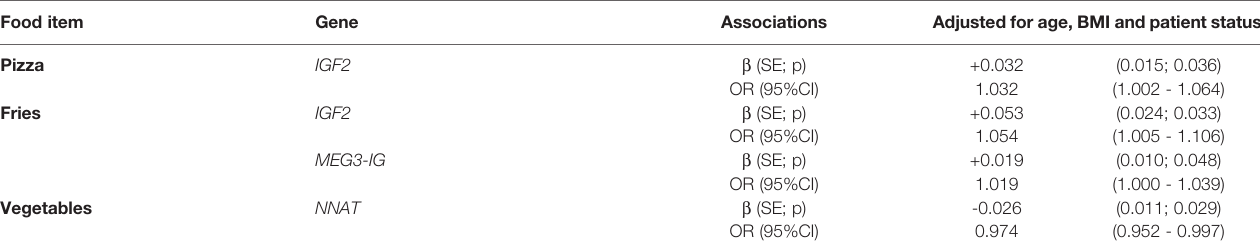
TABLE 6 | Associations between diet and the mean DNA methylation level at imprinted genes. Food